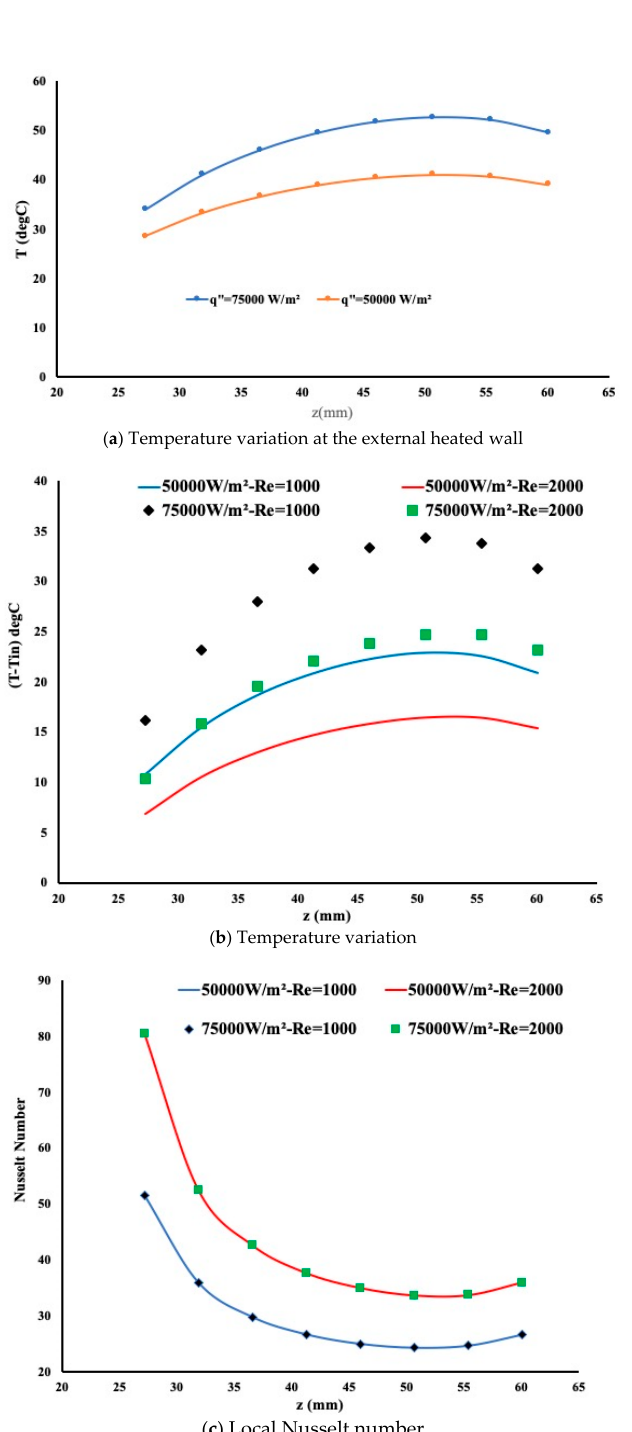
Figure 4. Temperature and the Nusselt number at the inner and external wall surface (no insert).